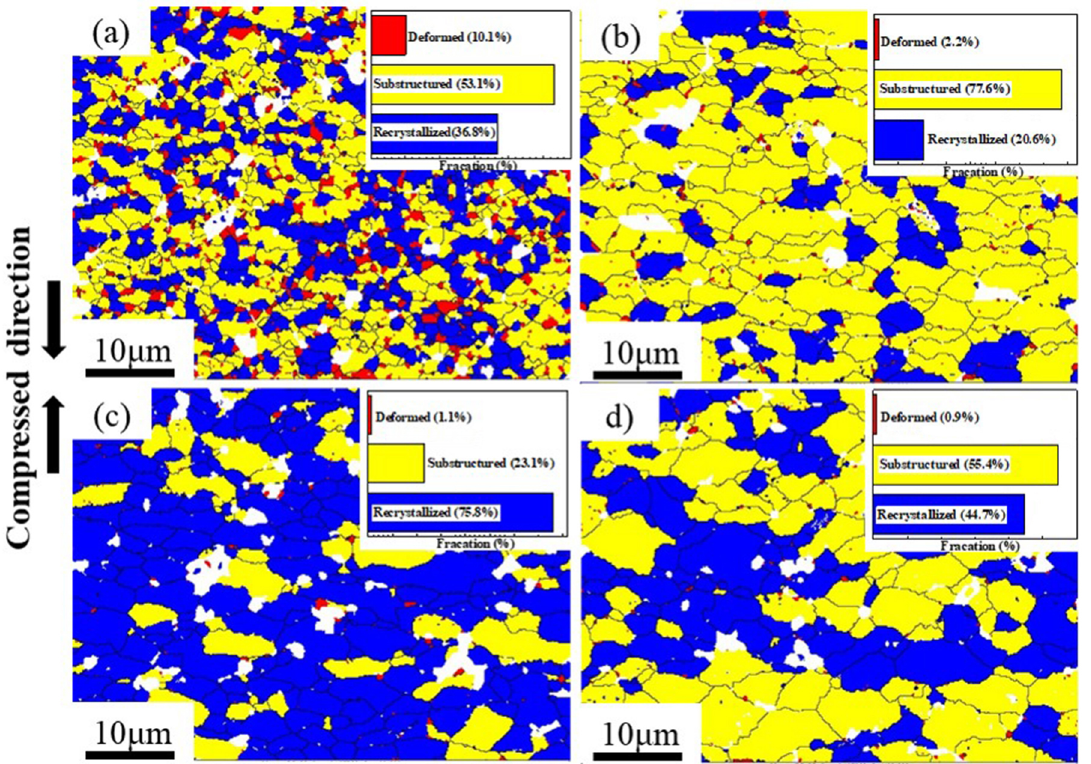
Figure 8. The recrystallized grains (blue parts), sub-grains (yellow parts) and deformed structure (red parts) in EBSD maps of samples compressed under di ff erent Z values: ( a ) lnZ = 30.0, ( b ) lnZ = 25.8, ( c ) lnZ = 21.7, ( d ) lnZ = 16.6 (HAGBs are in black lines, the inset figures are the percentages of recrystallized, substructured and deformed grain parts of the